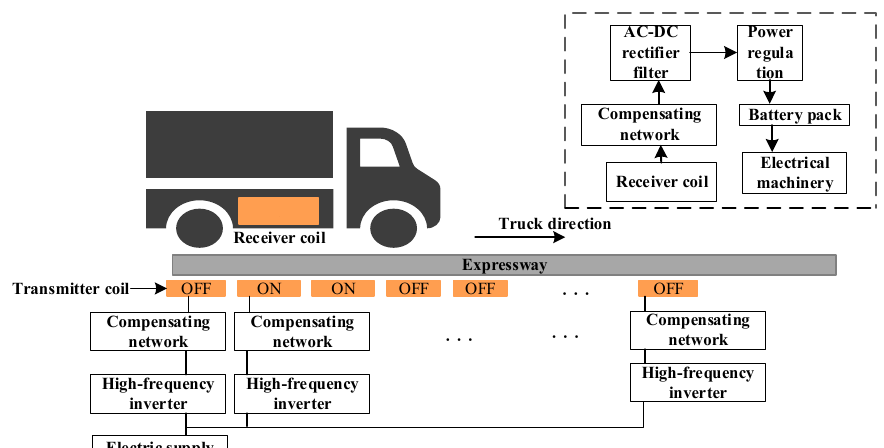
Figure 1. Dynamic wireless charging schematic.